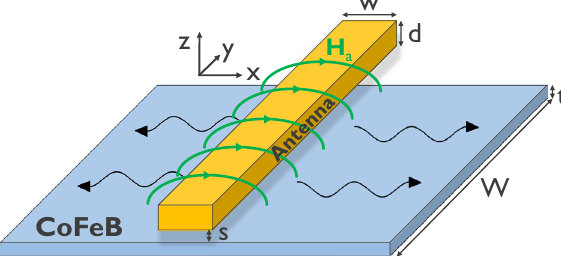
Figure 2. Schematic of the studied geometry: wire antenna (yellow) on top of a ferromagnetic narrow waveguide or thin film (blue). The static magnetization inside the waveguide or thin film can take any arbitrary direction in the general